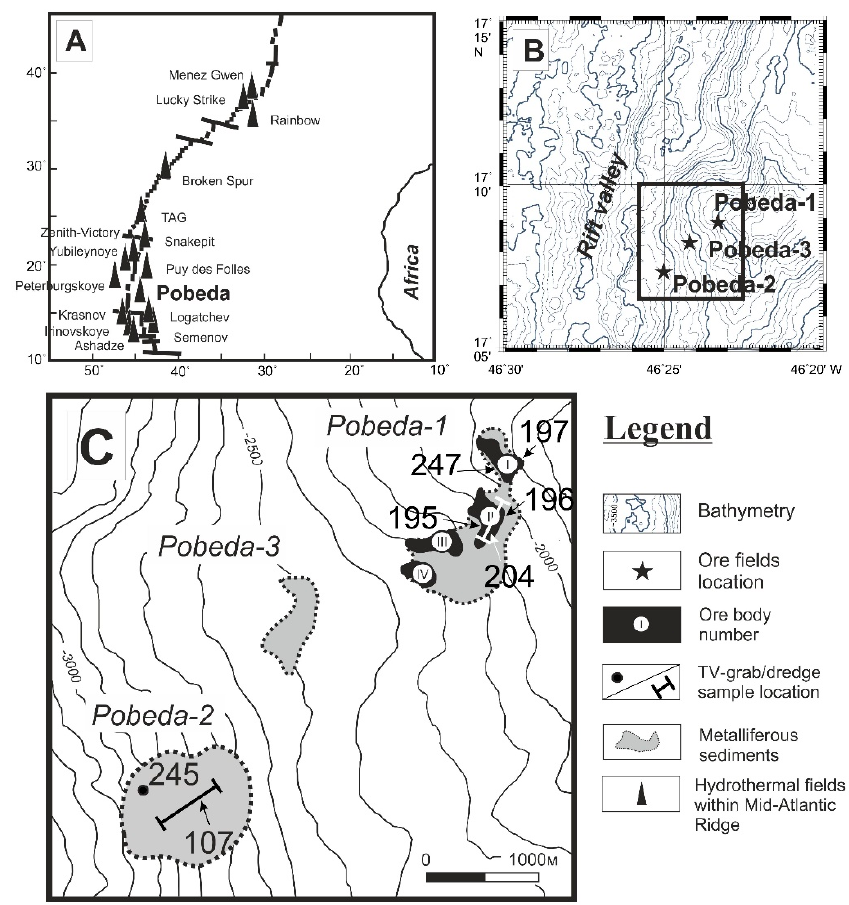
Figure 1. Geological setting of the Pobeda massive sulfide hydrothermal cluster. (A) Location of the Pobeda cluster at the Mid-Atlantic Ridge; (B) The Pobeda -1, 2 and 3 hydrothermal fields at the Mid- Atlantic Ridge bathymetry; (C) Detailed scheme of hydrothermal fields with the sampling station